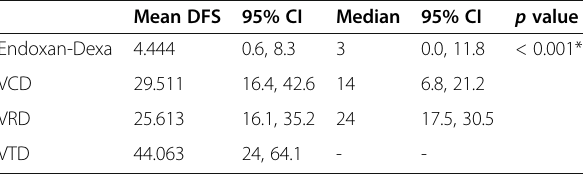
Table 6 Kaplan-Meier analysis for DFS between the different treatment